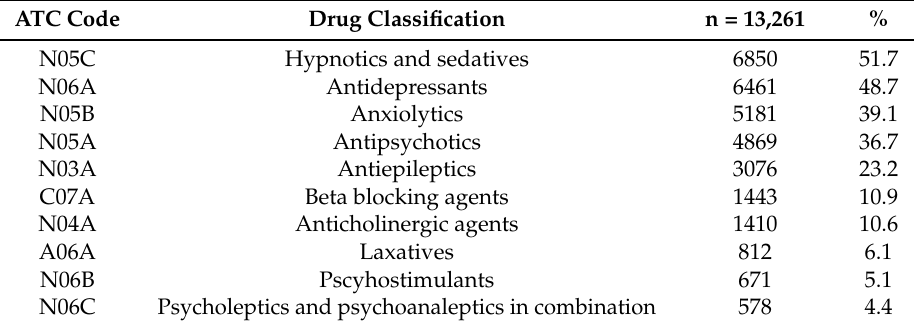
Table 3. The prescription of drugs by Anatomical Therapeutic Chemical (ATC) 3rd level.